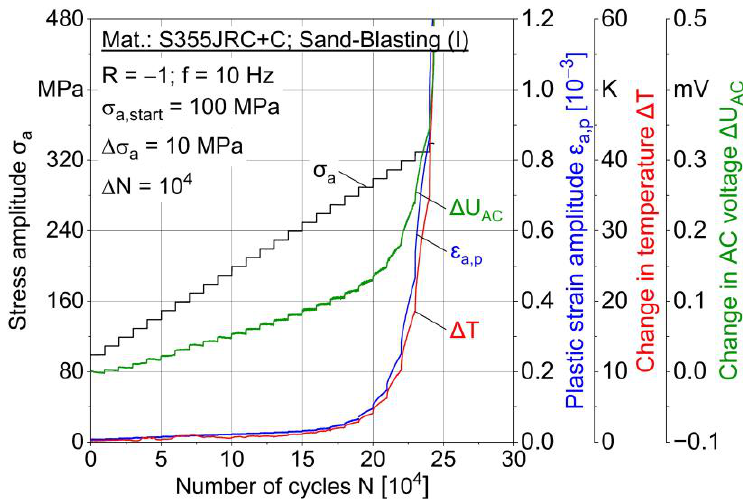
Figure 11. Multiple amplitude test (MAT) for sandblasted (I) specimen.